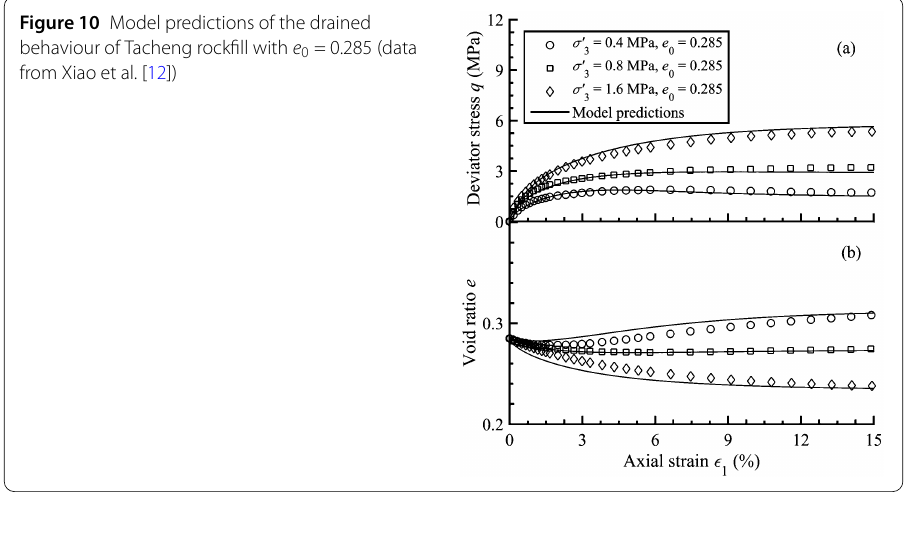
Figure 11 Model predictions of the drained behaviour of Tacheng rockfill with e 0 = 0.317 (data from Xiao et al.